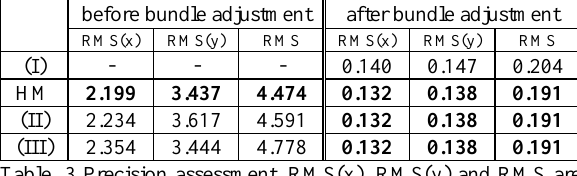
Table. 3 Precision assessment. RMS(x), RMS(y) and RMS are the RMS (root mean square) of reprojection residuals (in pixels) in image space in horizontal direction, vertical direction and Euclidean residual.